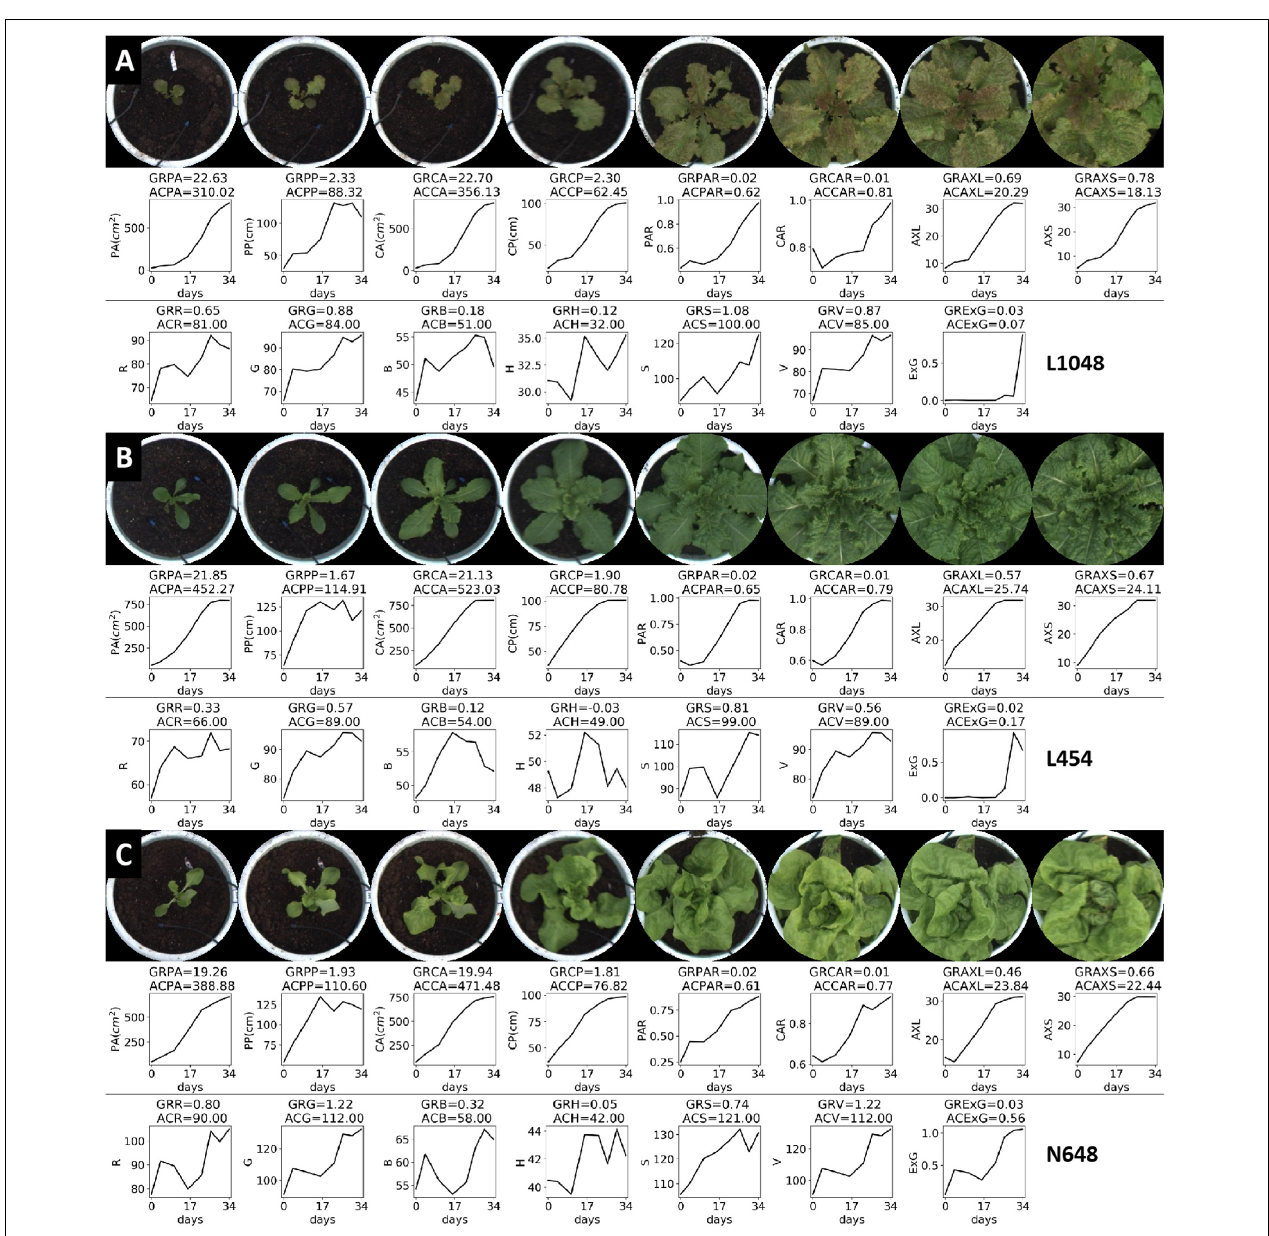
FIGURE 7 | Top-view image sequence and dynamic traits of three lettuce varieties. For the three varieties, 15 static traits were collected from each plant, with corresponding line charts showing the changes in these traits over a 34-day period, and dynamic traits (GR-, AC-) were used to quantify these changes.